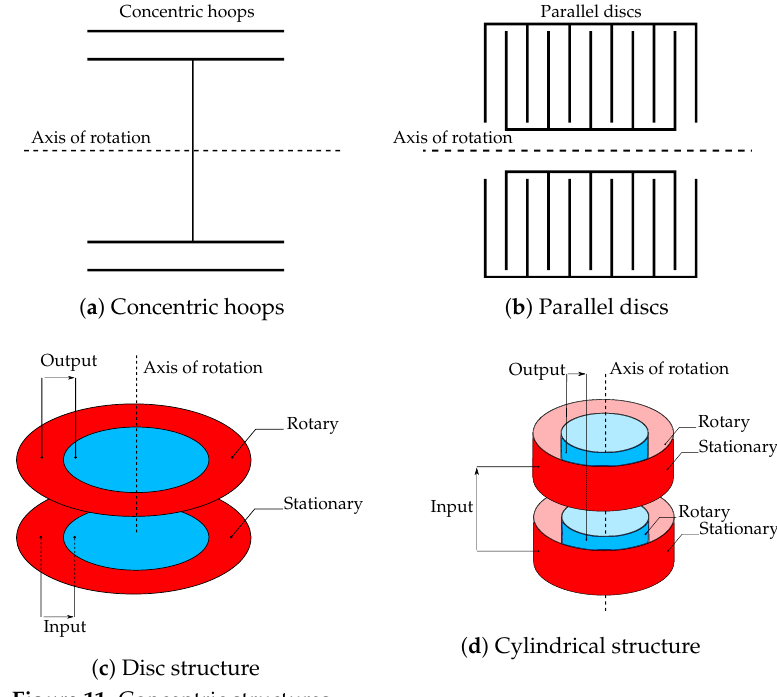
Figure 11. Concentric